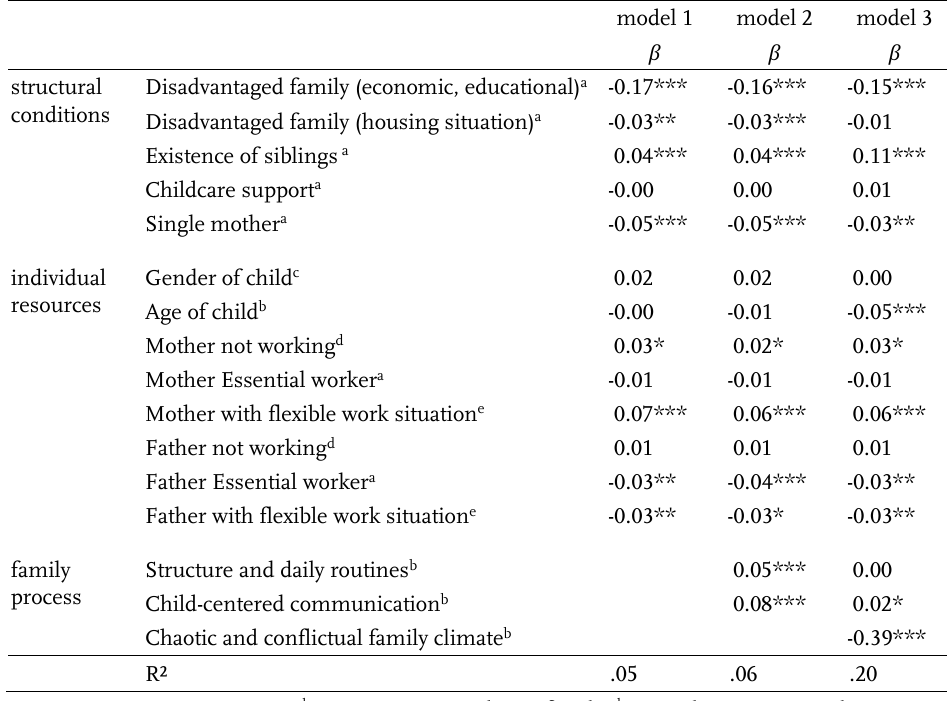
Table 5 Results of linear hierarchical regression analysis predicting child’s